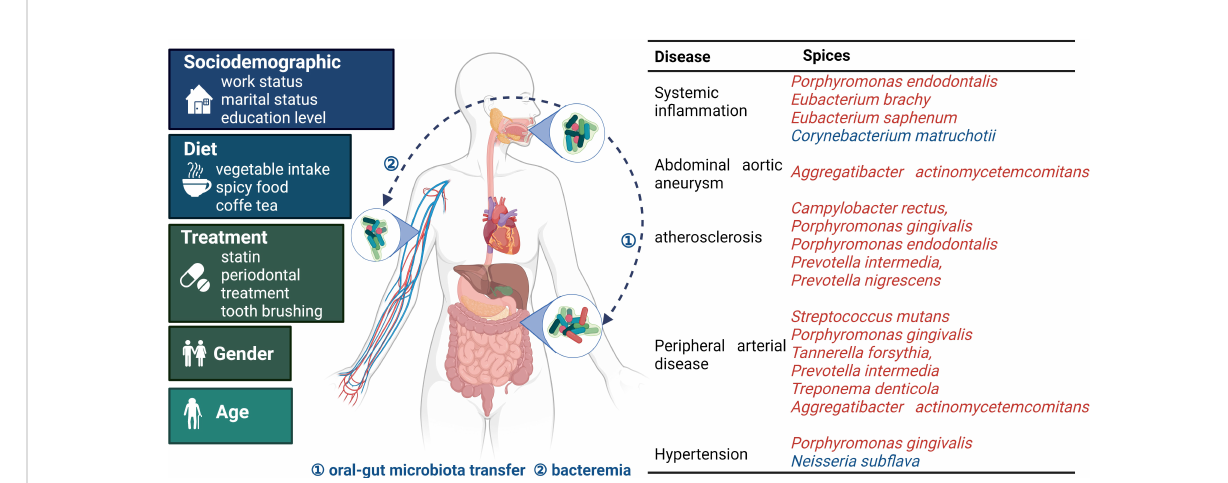
FIGURE 1 Oral microbiota and bacterial species related to cardiovascular disease occurrence The oral microbiota is in fl uenced by multiple factors. Pathogens gain entry into systemic tissues via oral-gut microbiota transfer and bacteremia, thereby endangering cardiovascular health. The table presents the relationship between the microbiota and speci fi c diseases. Red and blue indicate microorganisms with adverse and protective effects, respectively. Oral microbiota and cardiovascular disease common in fl uencing factors are on the left (7, 18, 47,